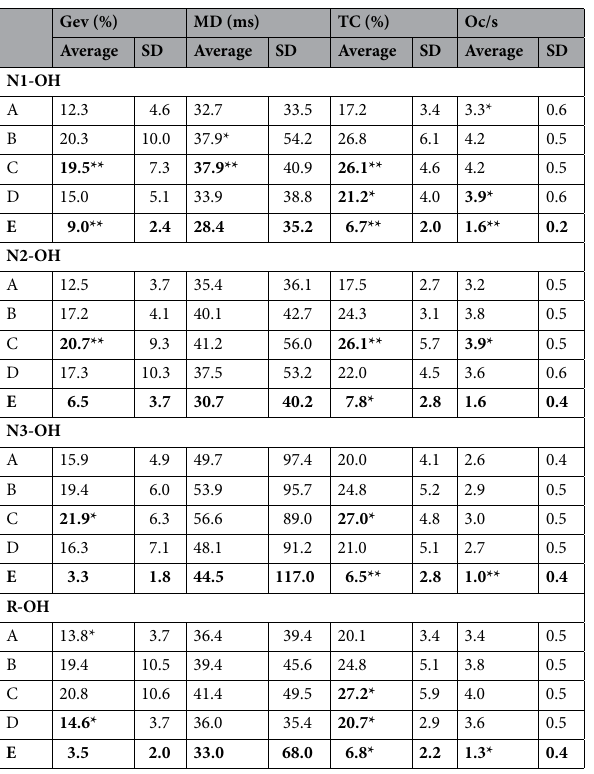
Table 3. Microstate parameters of 5 microstates in OSA-OH patients in 4 sleep stages. The stars indicate the significant difference at each sleep stage between OSA-OH and OSA-withoutOH patients (*P < 0.05, **P < 0.01). The bold value has significant difference, *P < 0.05, **P < 0.005.